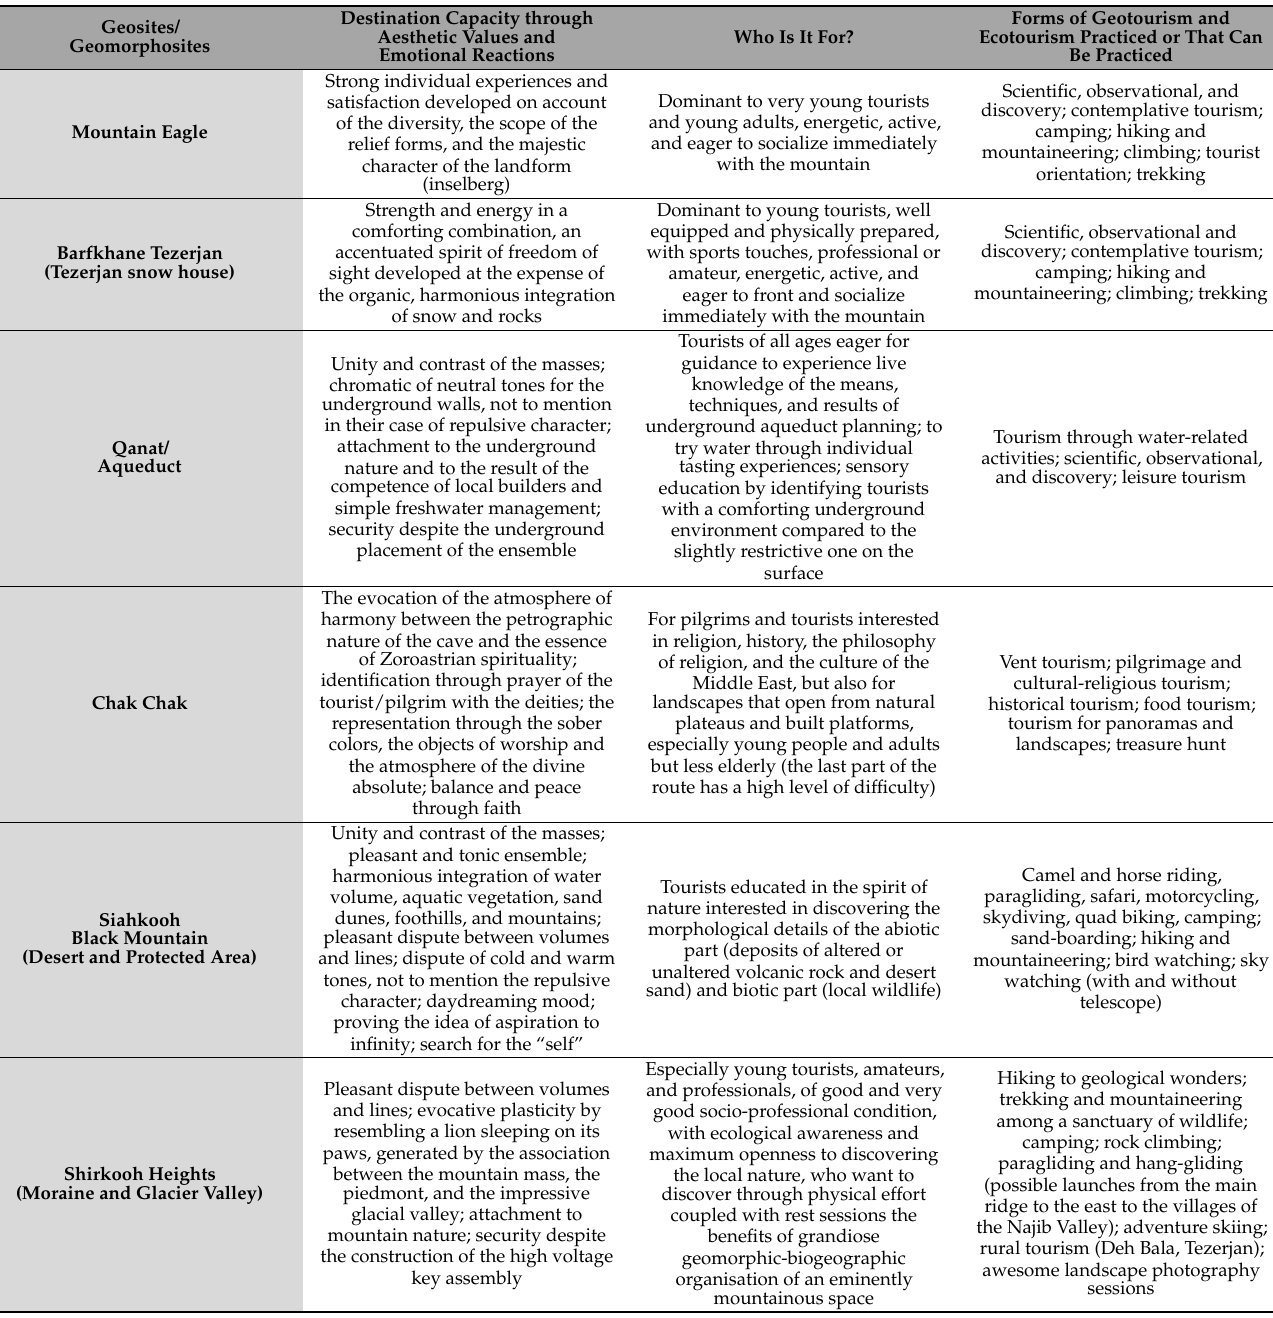
Table 4. The identity of the landscapes in the area defined by the emotions and reactions developed by tourists, contributing to the promotion and practice of geotourism and